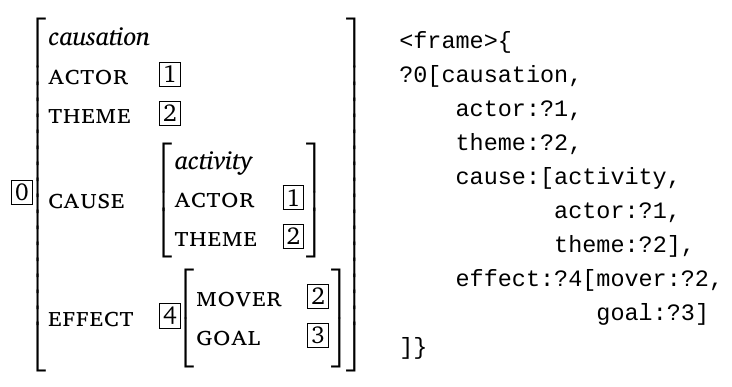
Figure 11: Specification of the